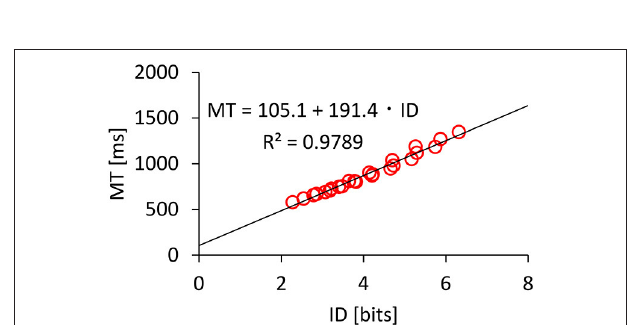
FIGURE 3 | Main effects of (A) target distance A and (B) target width W on MT . (C) The interaction effect of A intervals.